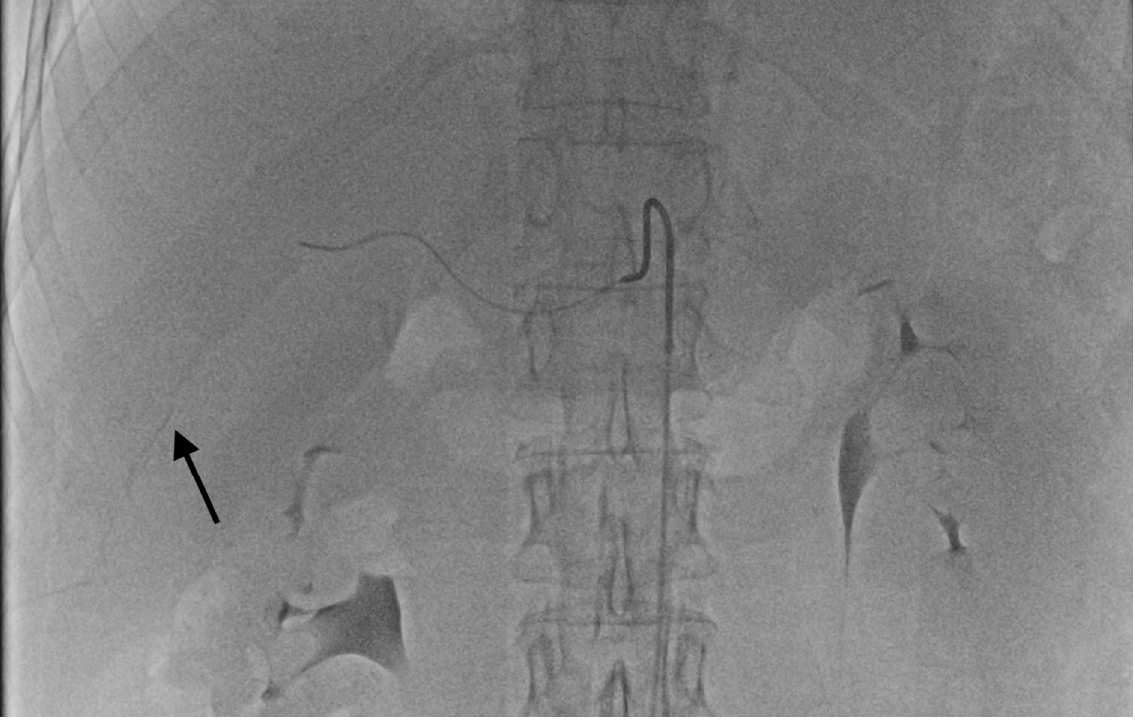
Figure 3. Temporary stasis at the level of subsegmental vessels of right hepatic artery (arrow).